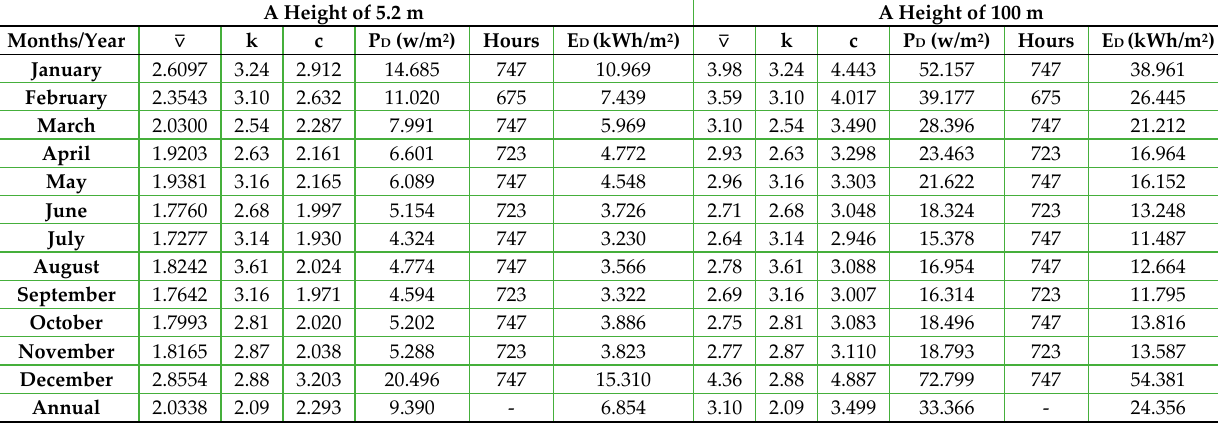
Table A3. Wind power and energy density characteristics at height of 5.2 m and 100 m in Kuala Terengganu.